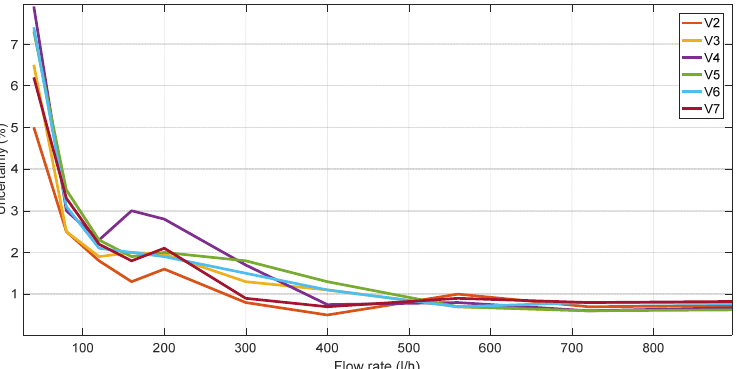
Figure 8. Uncertainty of different mechanical V-designs at low flow rates.